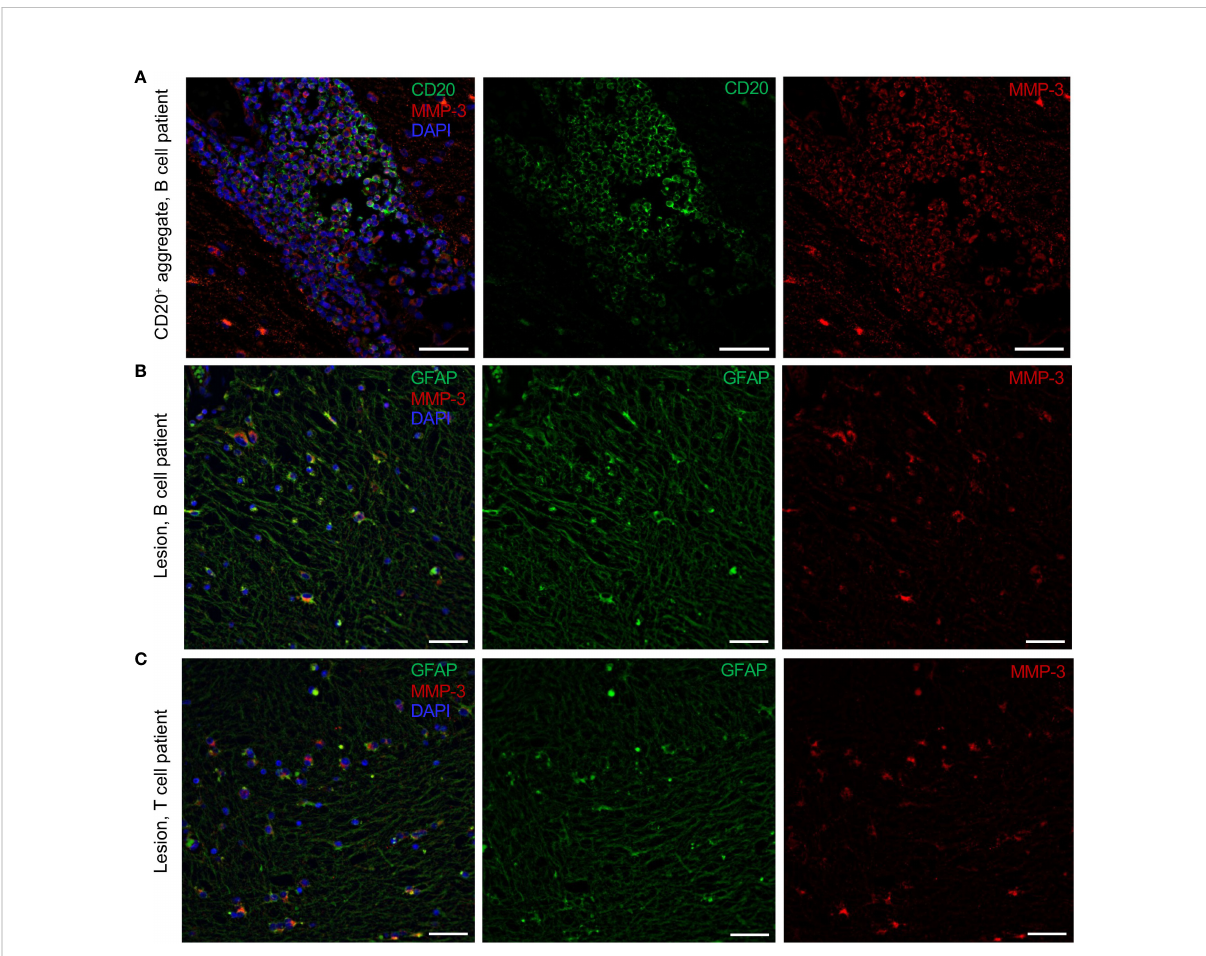
FIGURE 2 Cellular sources of MMP-3 expression in the MS brain. (A) Representative image of perivascular CD20 + MMP-3 + B cells in MS brain sections. Parenchymal GFAP + MMP-3 + astrocytes in a (B) B cell patient and (C) T cell patient. Scale bars display 50